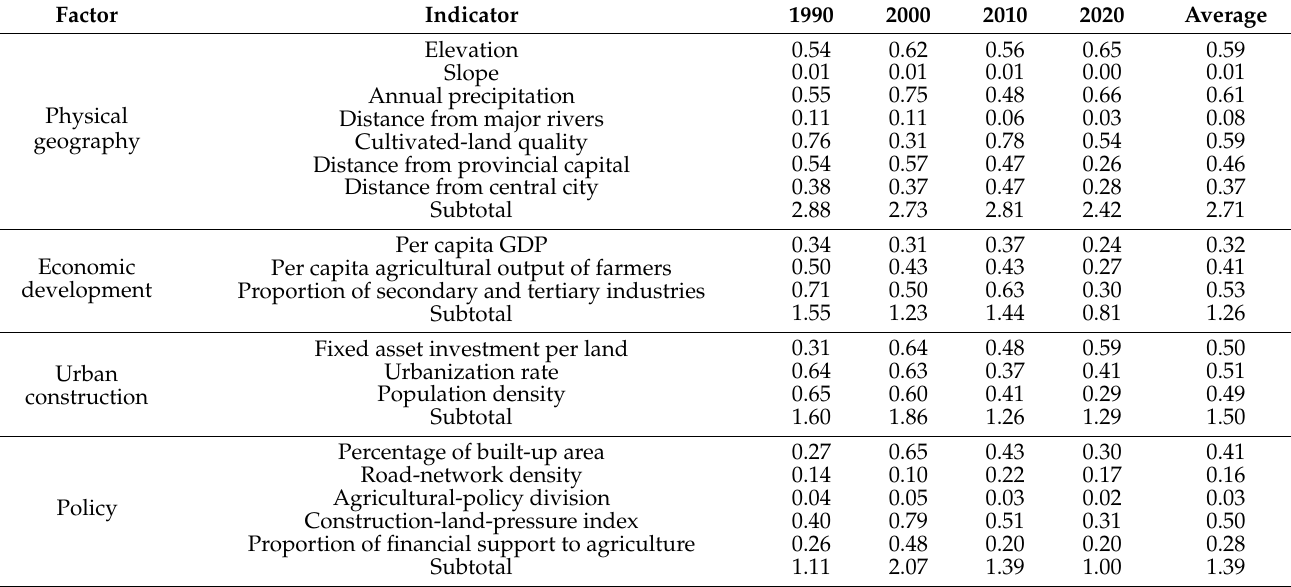
Table 6. Indicator values for factors influencing the multi-functionality of cultivated land in the black-soil breadbaskets of Jilin Province, Northeast China, from 1990 to